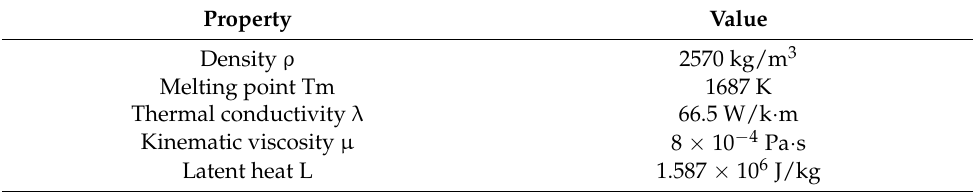
Table 1. Physical properties of